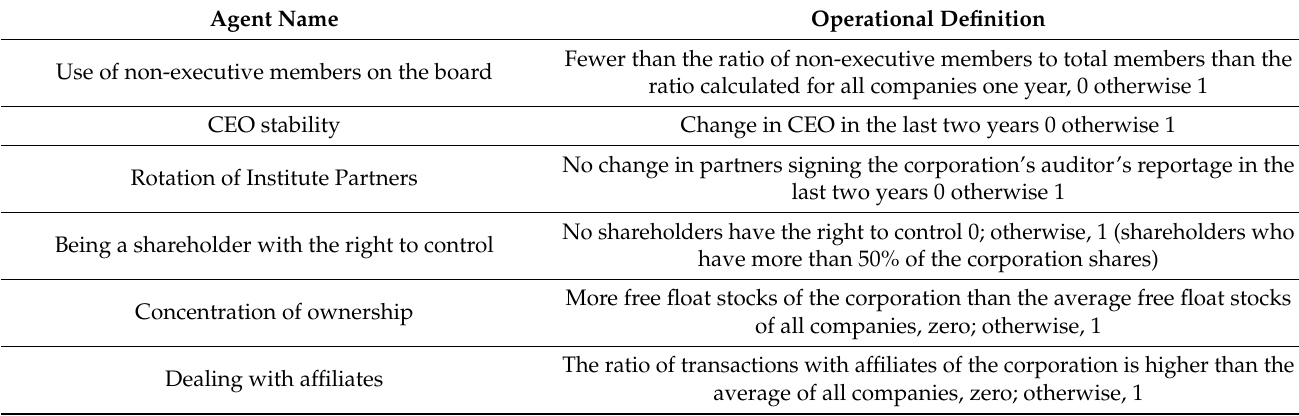
Table 3. Quality scores of corporate